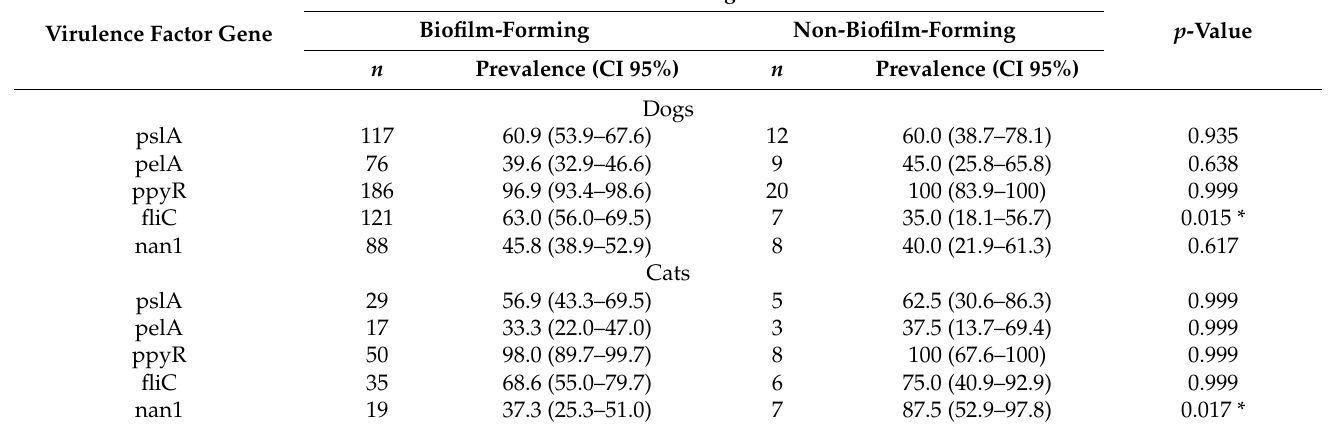
Table 4. Prevalence of virulence factor genes in 192 biofilm-forming and 20 non-biofilm-forming P. aeruginosa strains from dogs, and 51 biofilm-forming and 8 non-biofilm-forming P. aeruginosa strains